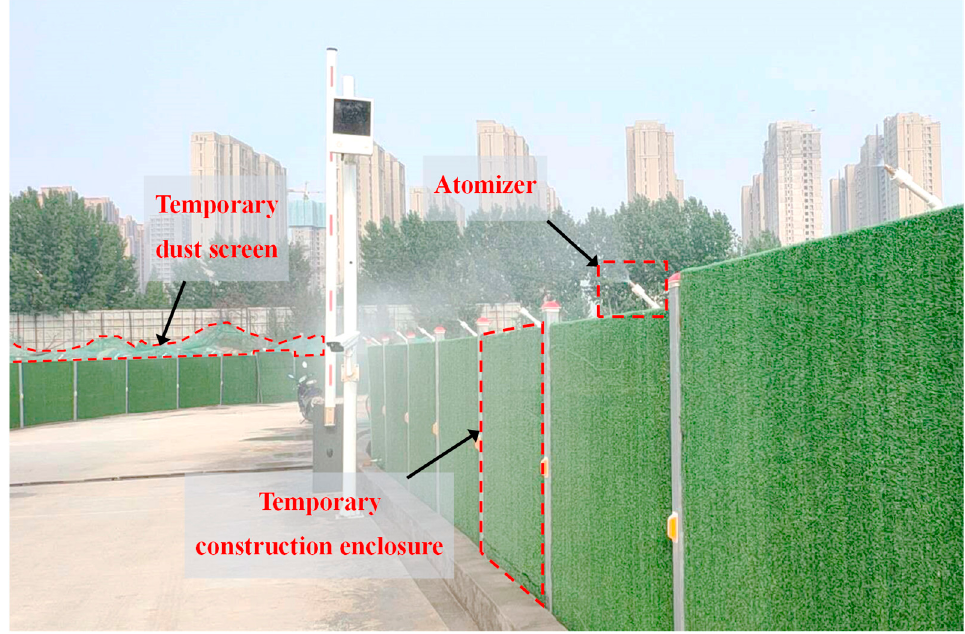
Figure 8. Temporary construction enclosure, dust screen, and atomizer.